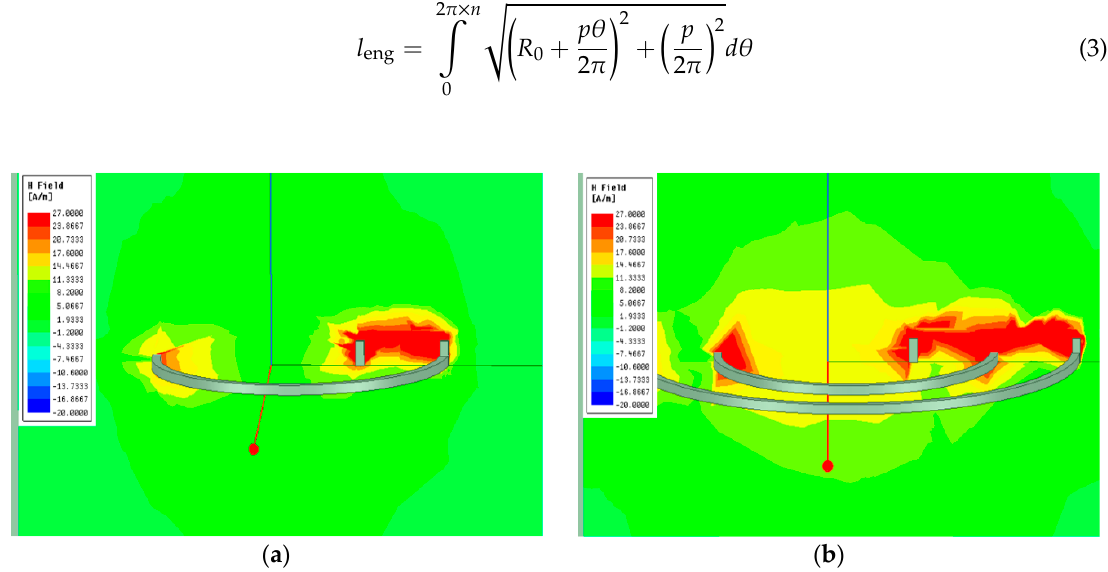
Figure 3. Magnetic field strength in ( a ) a one-turn coil and ( b ) a two-turn coil.